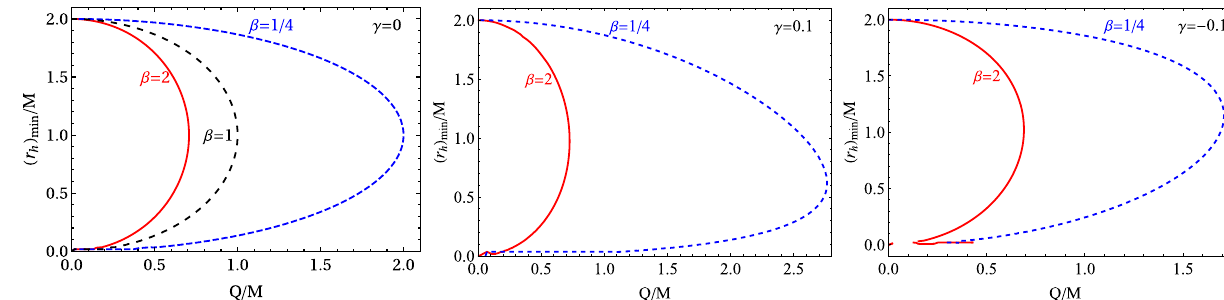
condition U ( r ) = 0. In Fig. 1 the dependence of event hori- zons’ from theBH chargeat zero(topleft panel), positive(top right panel), and negative (bottom panel) values of parameter γ forthedifferentvaluesoftheparameter β havebeenshown.